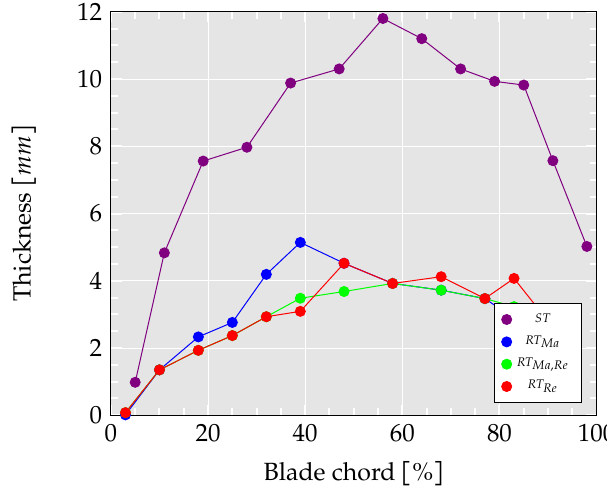
Figure 12. Evolution of boundary layer in terms of thickness.